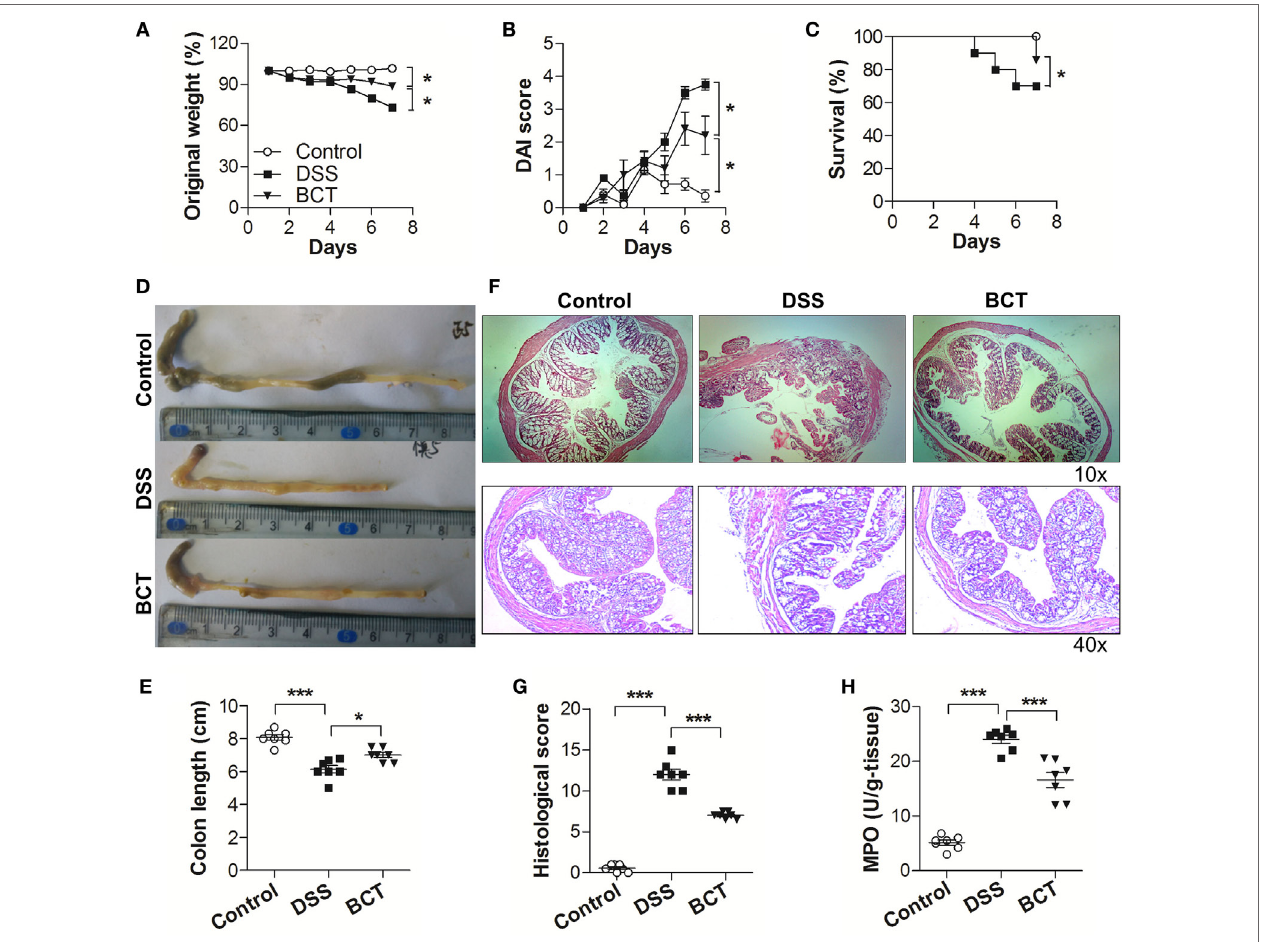
FigUre 1 | BCT ameliorated DSS-induced colitis in mice. The effect of BCT on DSS-treated mice was assessed by (a) change of original weight; (B) Disease Activity Index score; (c) survival rate; (D,e) the colon length was determined after sacrifice; (F) H&E-stained results for the sections of mouse colon; (g) histopathological analysis of the H&E-stained sections; (h) the myeloperoxidase of colonic tissue was detected by ELISA following the manufacturer’s protocol. All data were evaluated as mean ± SEM ( n = 5). Statistical analysis of the quantitative multiple group comparisons was performed using the one-way analysis of variance followed by Tukey’s test, * p < 0.05, *** p <